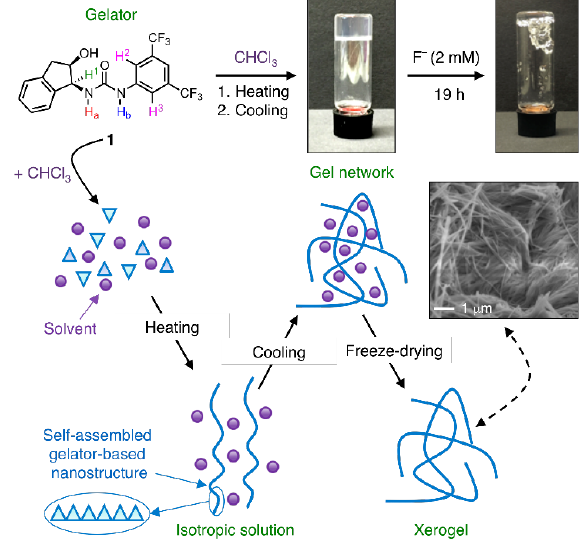
Figure 1. Illustration of the formation of the supramolecular organogel made of urea 1 in chloroform ( c = 8 g·L −1 ) and its observed disruption upon addition of fluoride. The fibrillar nature of the gel was observed by scanning electron microscopy of the corresponding xerogel.